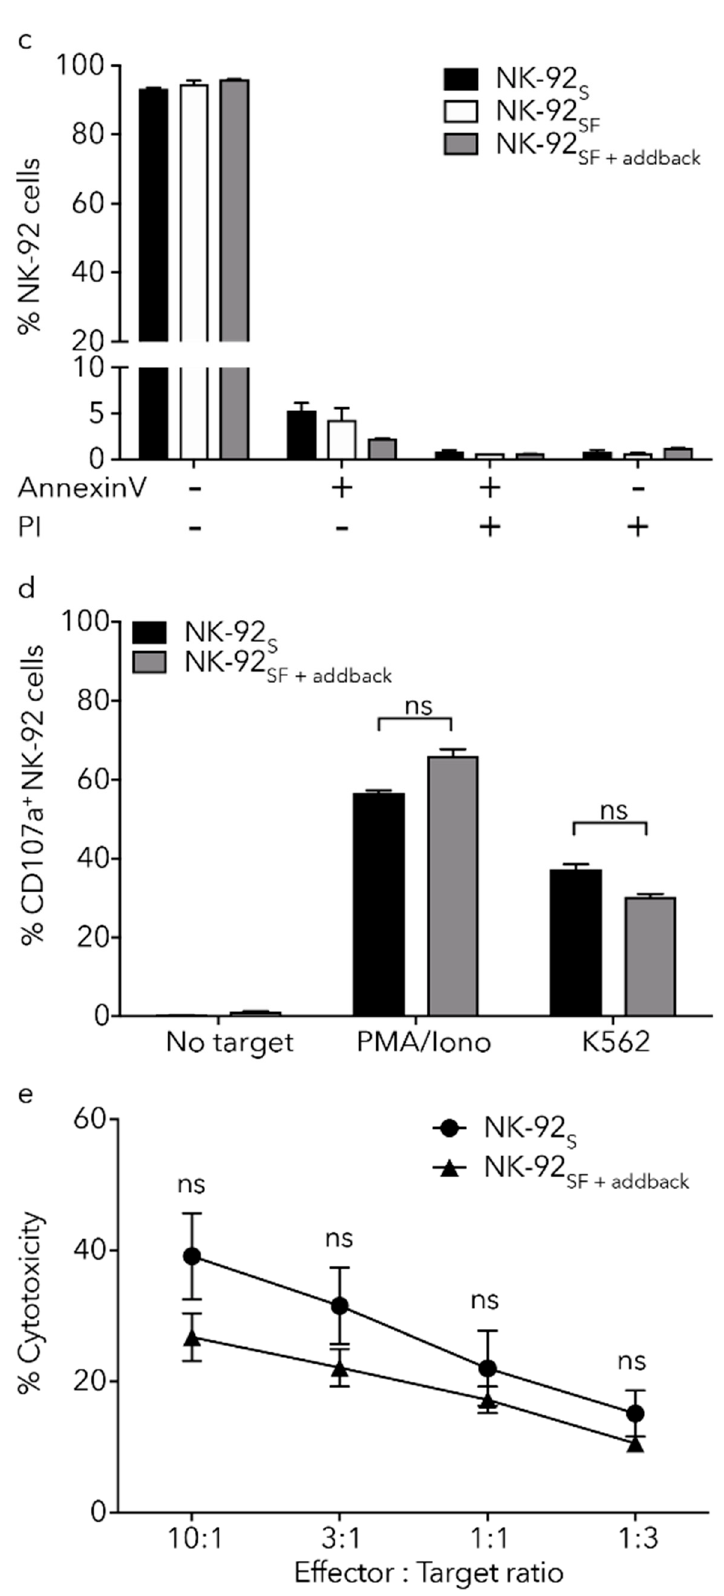
Figure 6. Addback of serum to NK-92 SF cells recovers killing capacity. ( a ) NK-92 SF show lower degranulation capacity against K562 target cells during a 5 h co-culture compared to NK-92 S . NK-92 SF cells were cultured in 20% serum-containing media for 16 h (NK-92 SF+addback ) and degranulation was tested against K562 target cell line. ( b ) Re-introduction of 20% serum for 16 h (NK-92 SF+addback ) increases killing capacity in a 4 h chromium release assay significantly. ( c ) NK-92 SF cells are able to recover from freezing and thawing and show no altered viability 72 h post-thaw regardless of serum